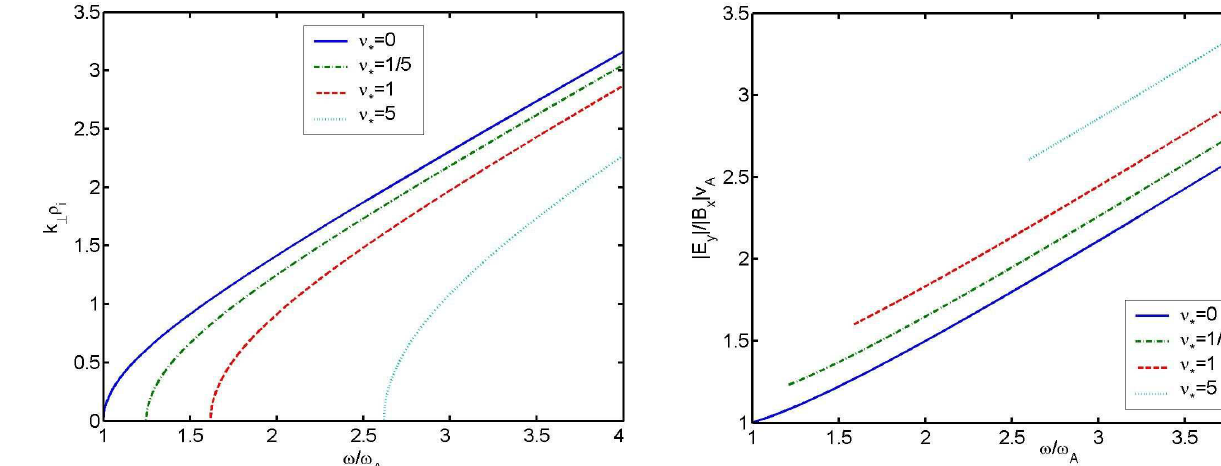
Fig. 1. The dependence of the perpendicular wave number normal- ized on the ion Larmor radius upon the wave frequency normalized to the Alfv´en frequency. Calculations are carried out for the electron to ion temperature ratio T e /T i = 0 . 5. Solid, dash-dotted, dashed and dotted lines correspond to ν ∗ = 0 ; 1 / 5 ; 1 ; and 5, respectively. With the increase of the plasma inhomogeneity (corresponding to the in- crease of ν ∗ ) the wave frequency increases.